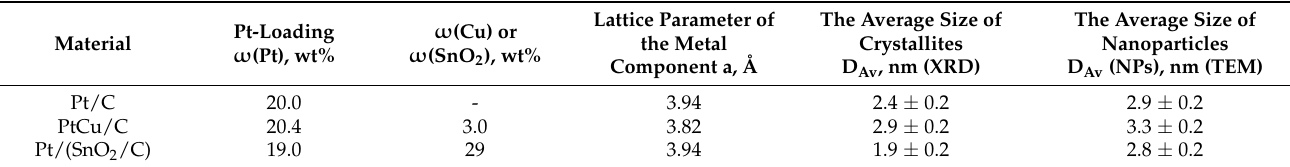
Table 1. Composition and structural characteristics of the obtained catalysts and commercial Pt/C material. Pt-Loading Material ω (Pt),